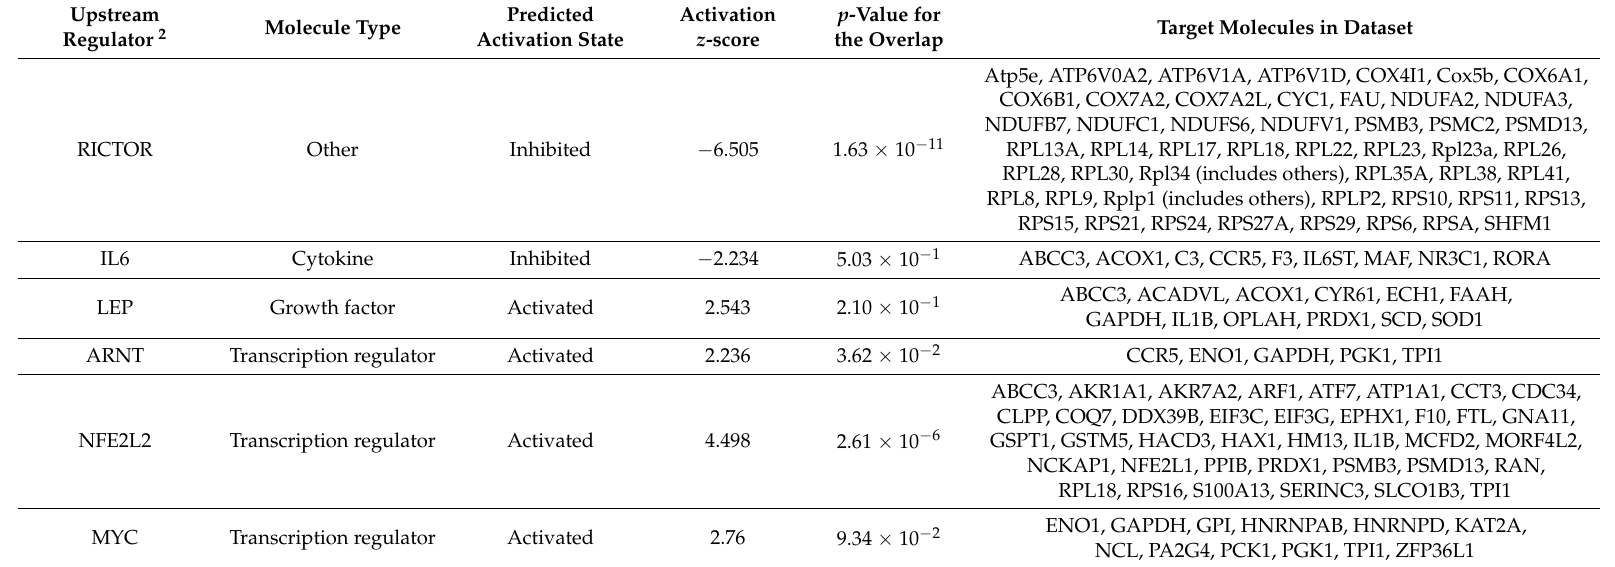
Table 3. Upstream regulators predicted to be altered by vitamin E in nonalcoholic steatohepatitis mice 1